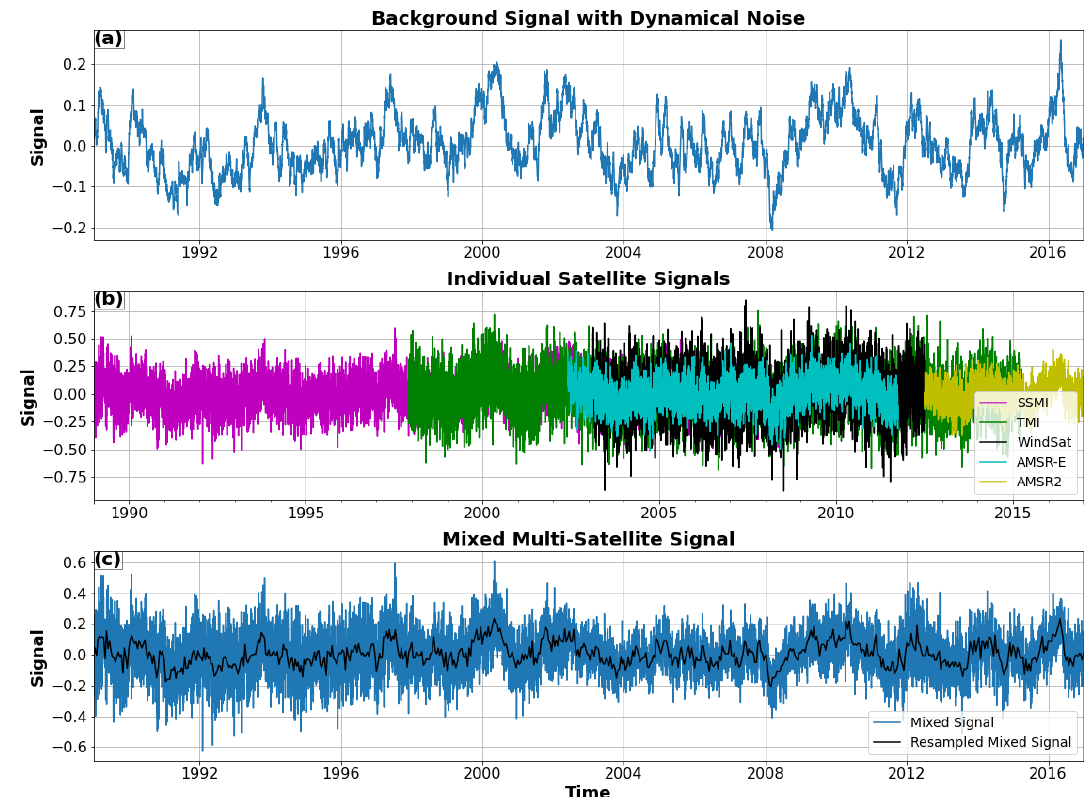
Figure 1. Synthetic experiment mimicking vegetation optical depth (VOD) time series, with relative measurement noise scaling ( R satellite ; see Methods) set to values between 1 for the most reliable sensor and 0.44 for the least reliable and signal-to-noise ratio (SNR; see Meth- ods) set to 1. (a) Ornstein–Uhlenbeck process with dynamical noise mimicking an underlying signal to be measured (see Methods). (b) Underlying signal plus additional white Gaussian measurement noise by individual synthetic sensor scaled by reliability R satellite , based on the characteristics of the satellites used in the VODCA data set (Moesinger et al., 2020) (see Table S1 in the Supplement and Methods for details). (c) Combined synthetic signal via taking the daily (blue) and bi-weekly (black)